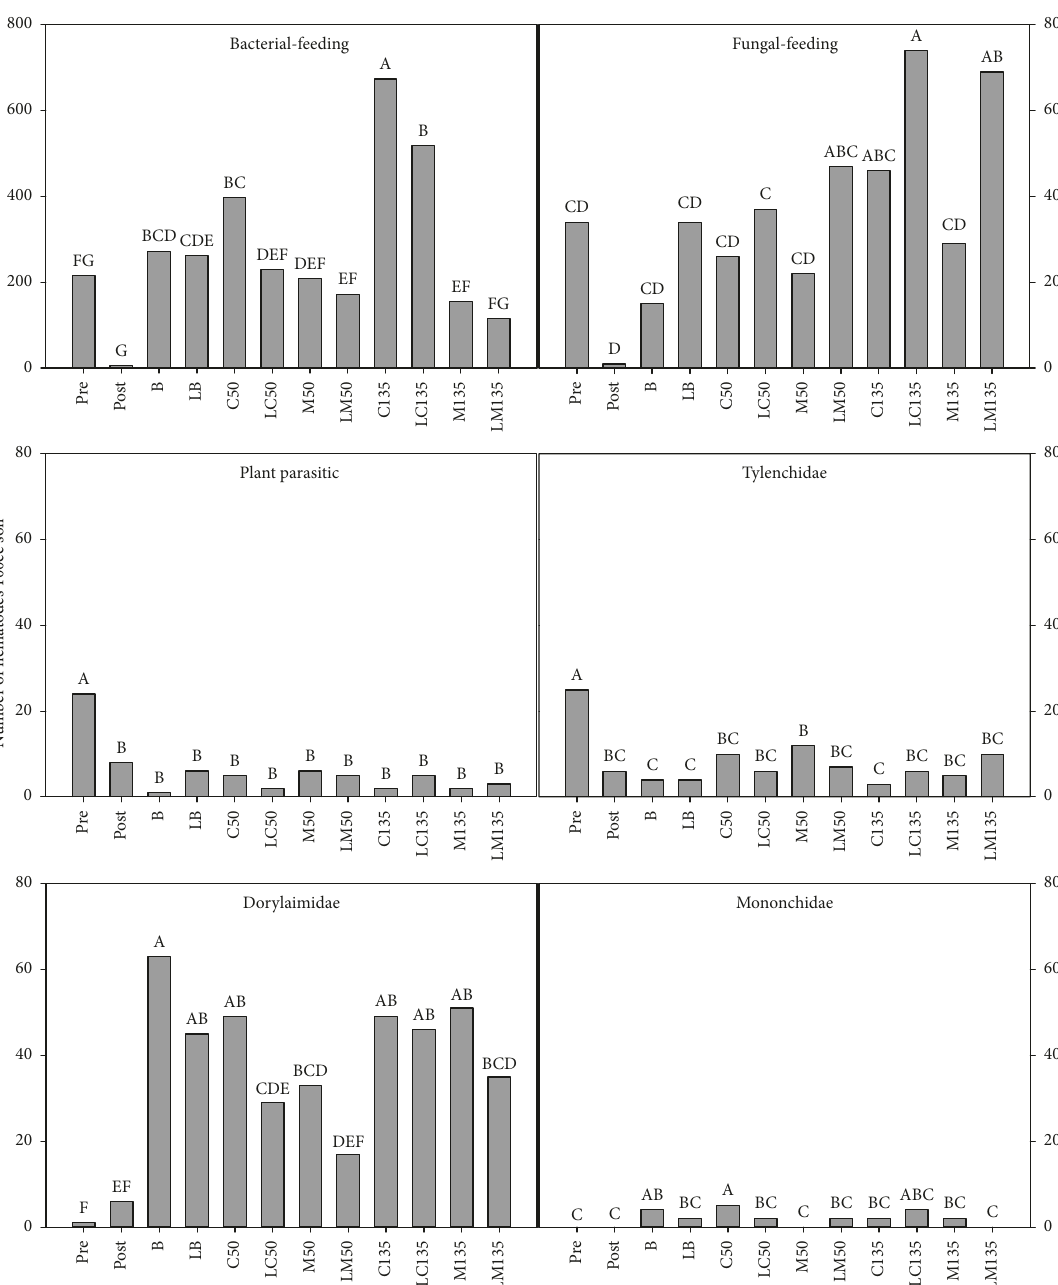
Figure 4: The x axis includes baseline soils before and after biosolarization (Pre and Post) and soils that received treatments applied to biosolarized soils: bare control with no amendment (B), bare with LEM inoculant (LB), compost at 50kg · N · ha − 1 and at 135 N · ha − 1 with and without LEM (C50, C135, LC50, and LC135), respectively, and mineral fertilizer at 50kg · N · ha − 1 and at 135N · ha − 1 with and without LEM (M50, M135, LM50, and LM135). Different letters indicate significant differences ( α �